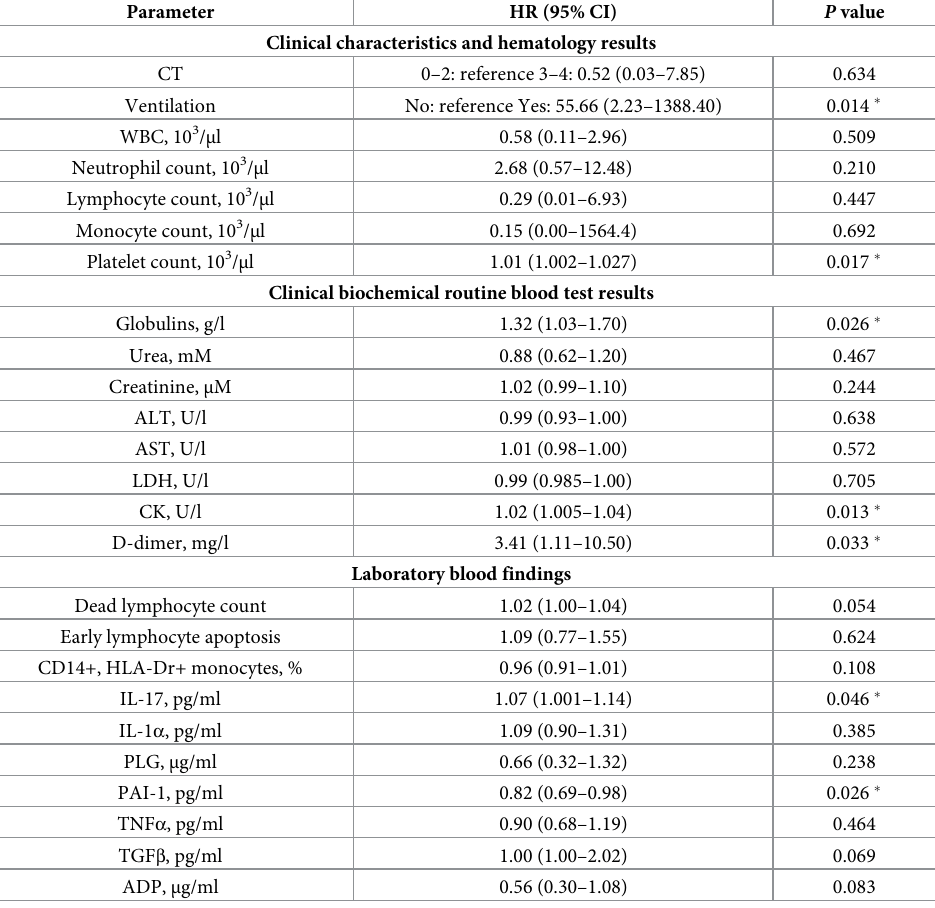
Table 2. Multivariable Cox proportional hazards survival analysis models for 3 groups of prognostic